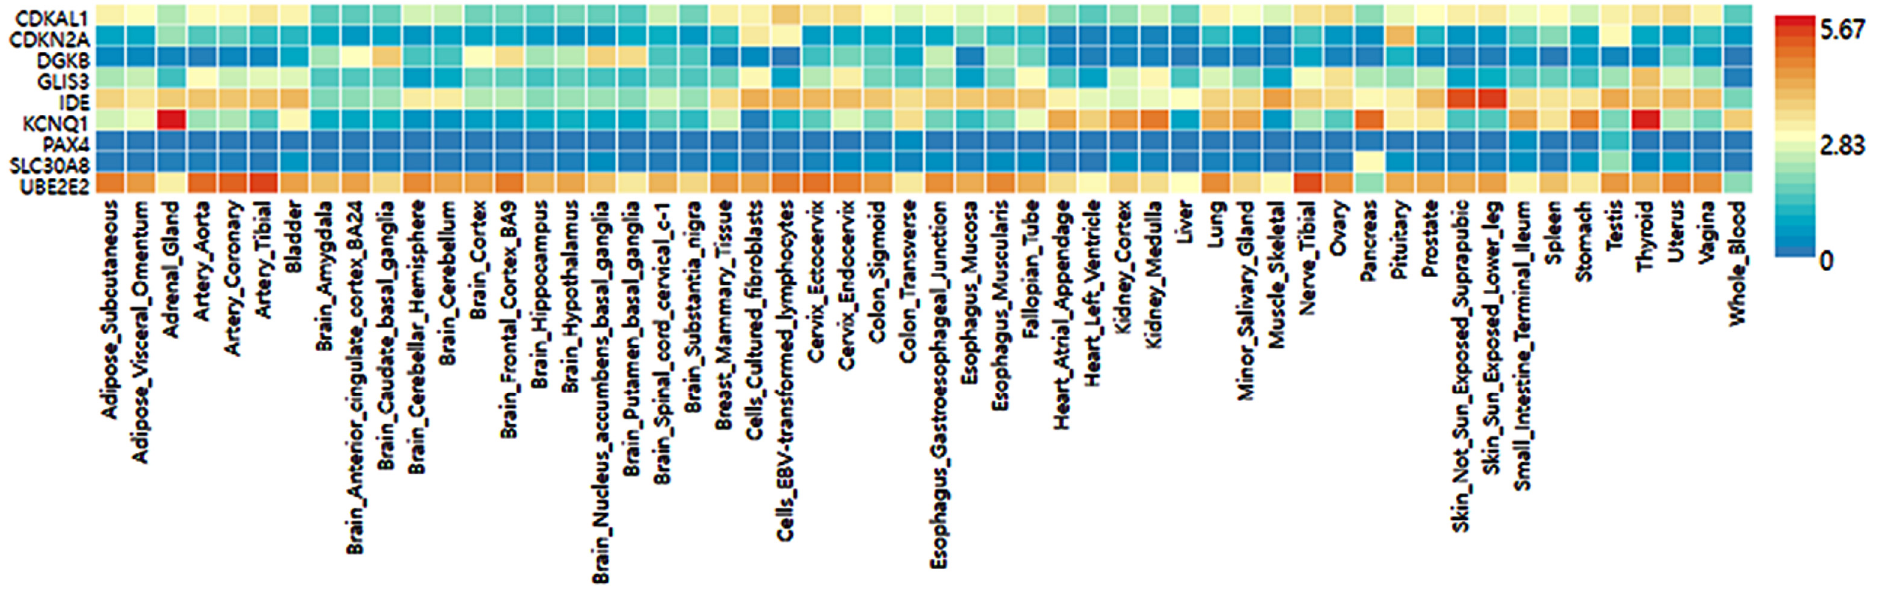
Figure 4. Genotype-Tissue Expression (GTEx) of genes according to their mutation.